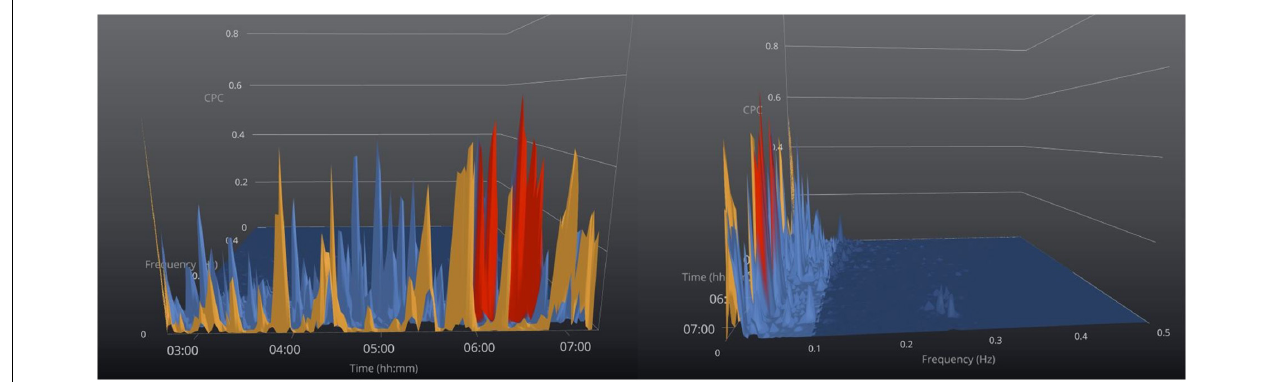
FIGURE 4 | Sleep apnea phenotyping. 3-Dimensional graphical view of the CPC- spectrogram in a patient with severe sleep apnea and no stable (HFC) sleep. Color code: orange = VLFC, blue = e-LFC BB (broadband coupling), and red = e-LFC NB (narrowband coupling). The offset view (right) shows the narrow dispersion of coupling frequencies induced by periodic breathing toward the end of the recording period, while earlier in the night the e-LFC spectra are “broadly dispersed,” consistent with predominantly obstructive sleep apnea. On the figure to the right the time axis is cut off and the figure is off set to show the narrow band best.